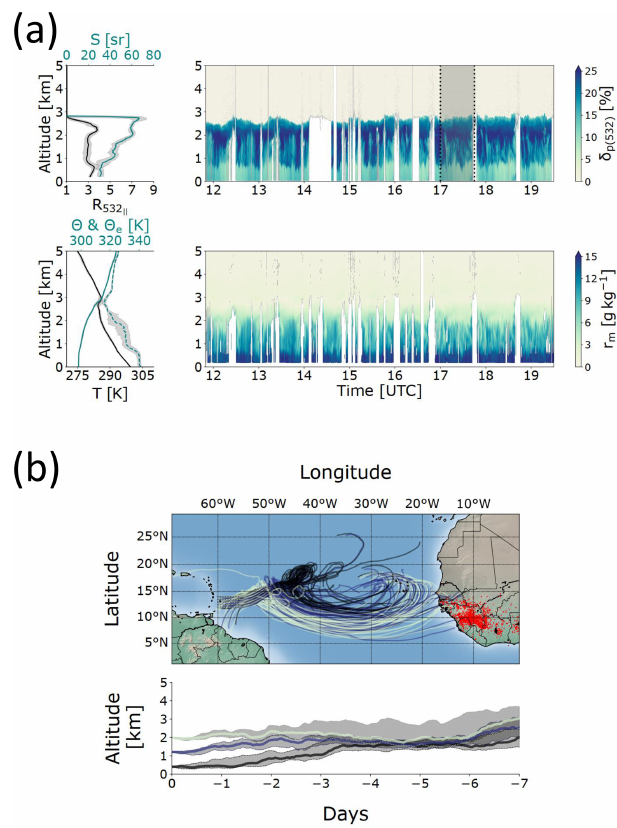
Figure 5. Same as Fig. 3 but for HALO-0202.